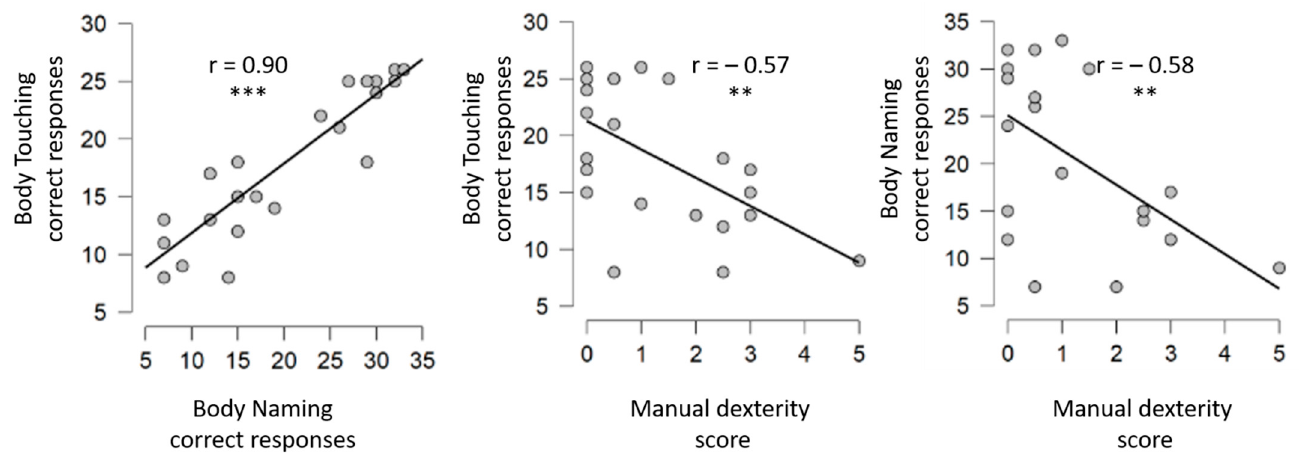
Figure 2. Correlation between body representation tasks and between body representation tasks and motor skills. ** is for p<0.01; *** is for p<0.001.